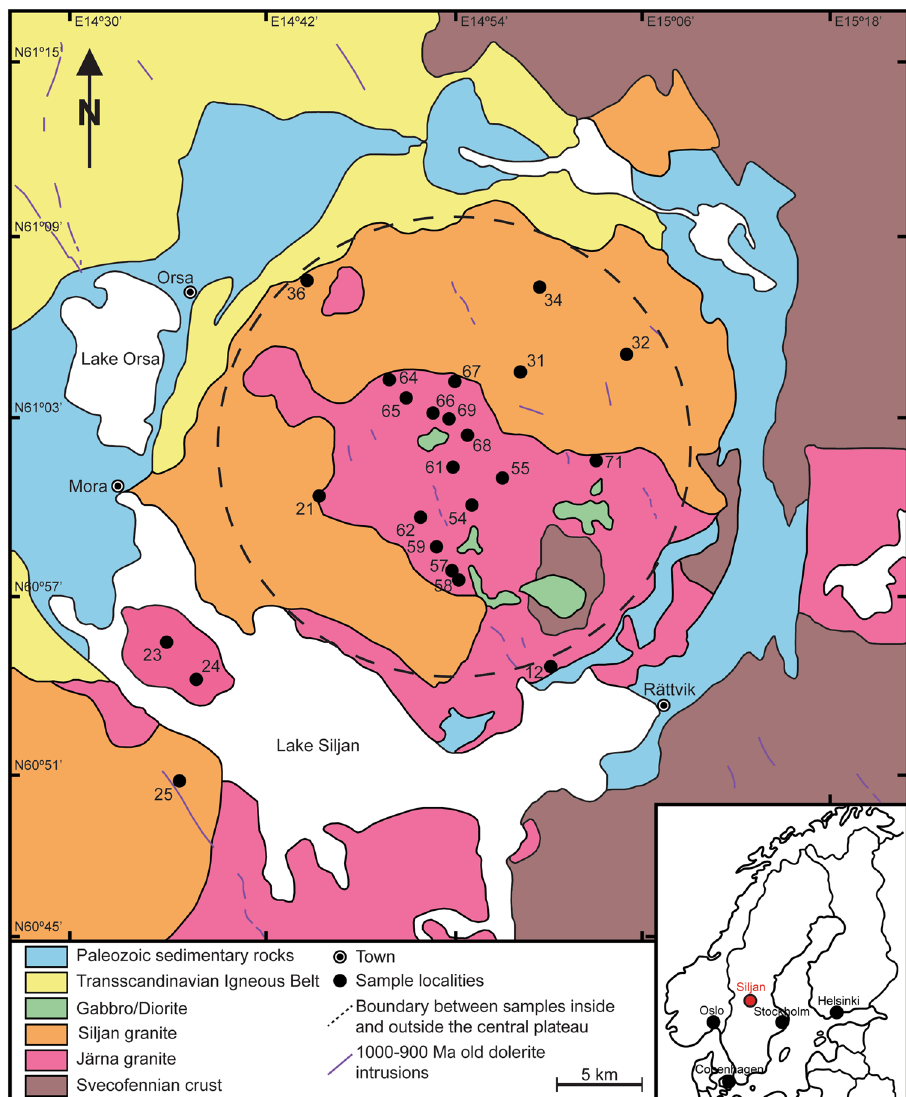
Figure 1. Geological map modified after 21 of the Siljan impact structure. Sample localities of Järna and Siljan granite inside and outside the central plateau are shown. The inset map shows the location of the Siljan impact structure in Sweden (red point). (Map modified with Adobe Illustrator version v. 25.0.1, https:// www. adobe. com/ produ cts/ illus trator. html? promo id= PGRQQ LFS& mv=